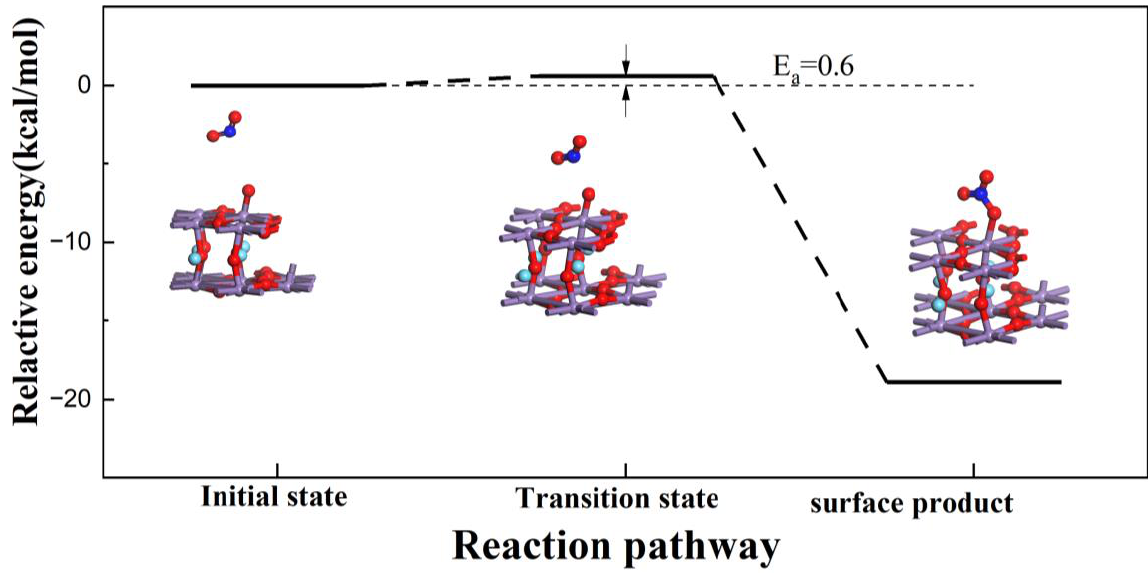
Figure 12. The formation process of NO 3 − .